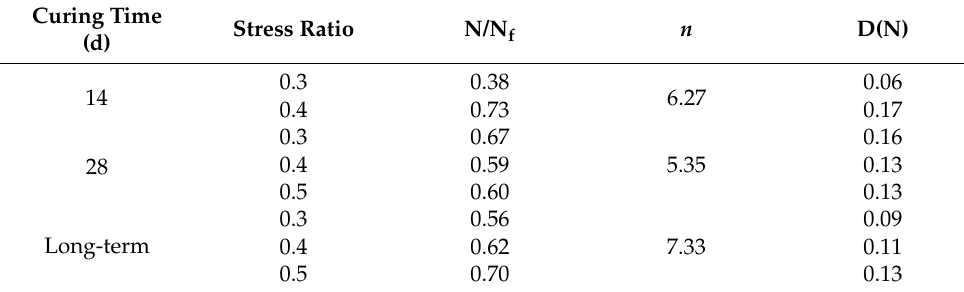
Figure 10. Damage evolution equations under different curing times with different stress ratios. Table 8. The fitting results of the damage variable.